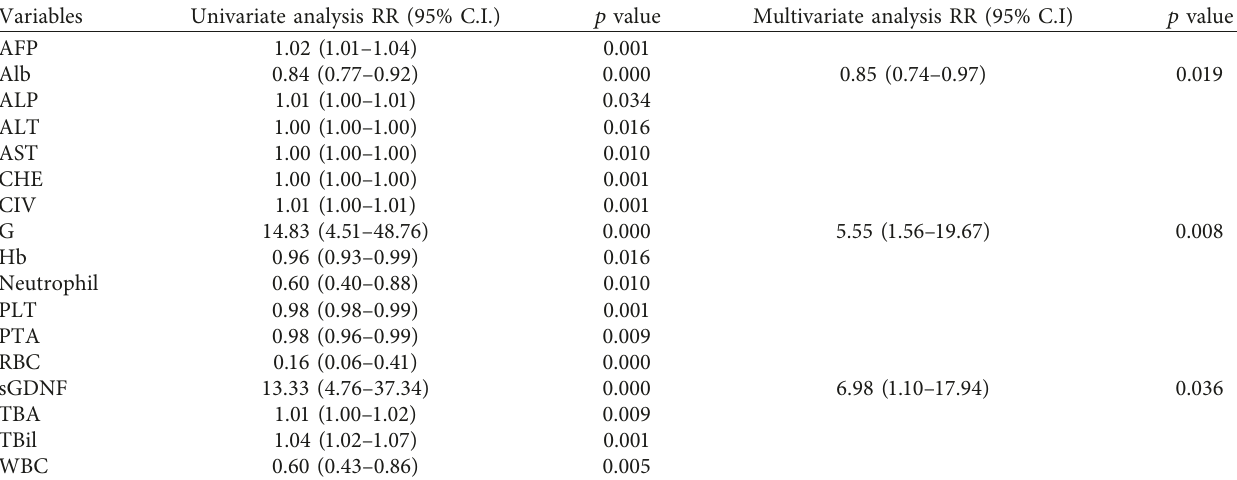
Table 4: Univariate and multivariate analyses producing odds ratio for significant F4 stage in chronic HBV patients. Variables